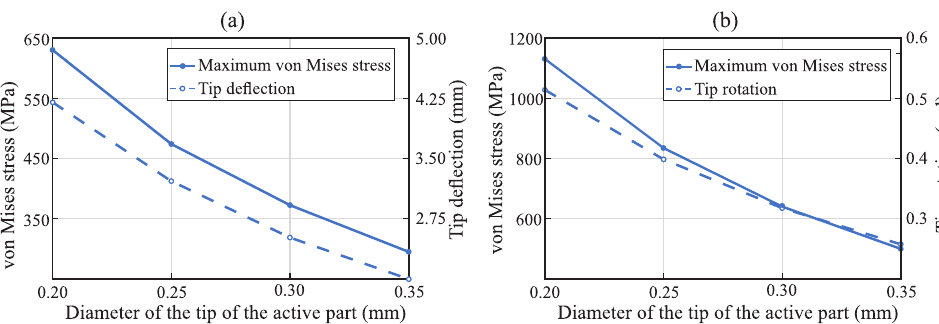
Figure 13. Results of the parametric study of the diameter of the tip of the active part: ( a ) bending analysis and ( b ) torsional